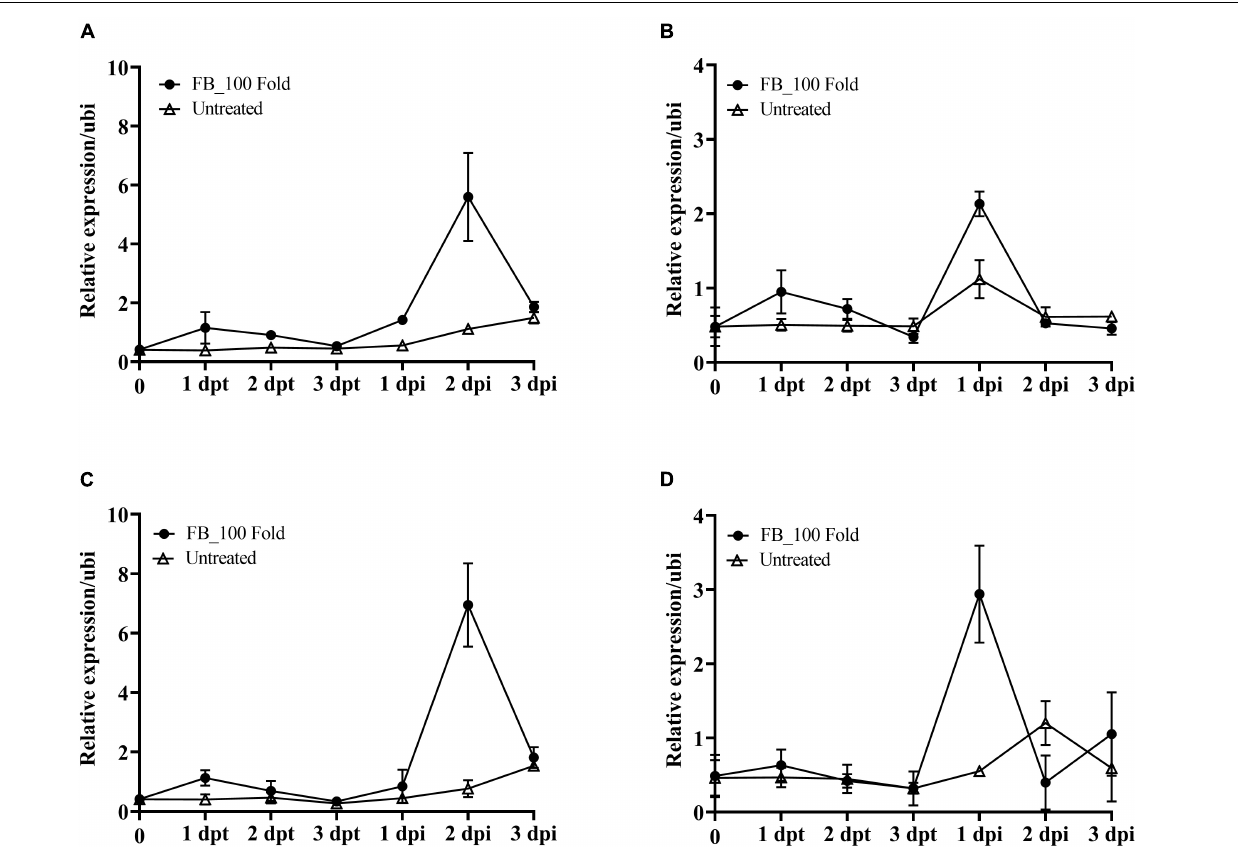
FIGURE 7 | Effect of the fermentation broth of Streptomyces sp. JCK-6131 on the gene expression levels of tomato plants before and after inoculation by Ralstonia solanacearum . The expression of the PR1 (A) , PR3 (B) , PR5 (C) , and PR12 (D) genes was analyzed from plants sprayed with 1% GSS (untreated) and treatment with 100-fold-diluted (FB_100 Fold) fermentation broth at different times, including 1, 2, and 3 days post treatment (dpt), and 1, 2, and 3 days post inoculation (dpi). The results display the average values ± SD ( n = 3) of three runs with three